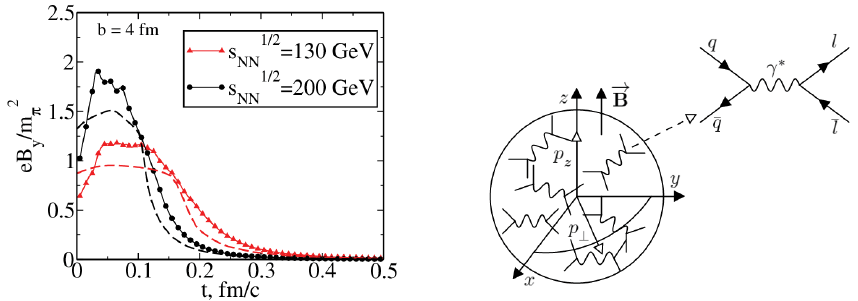
Figure 1. The strength of the magnetic field is plotted as a function of time in the left panel [3]. On the right panel we have a pictorial representation of lepton pairs coming out of a magnetised